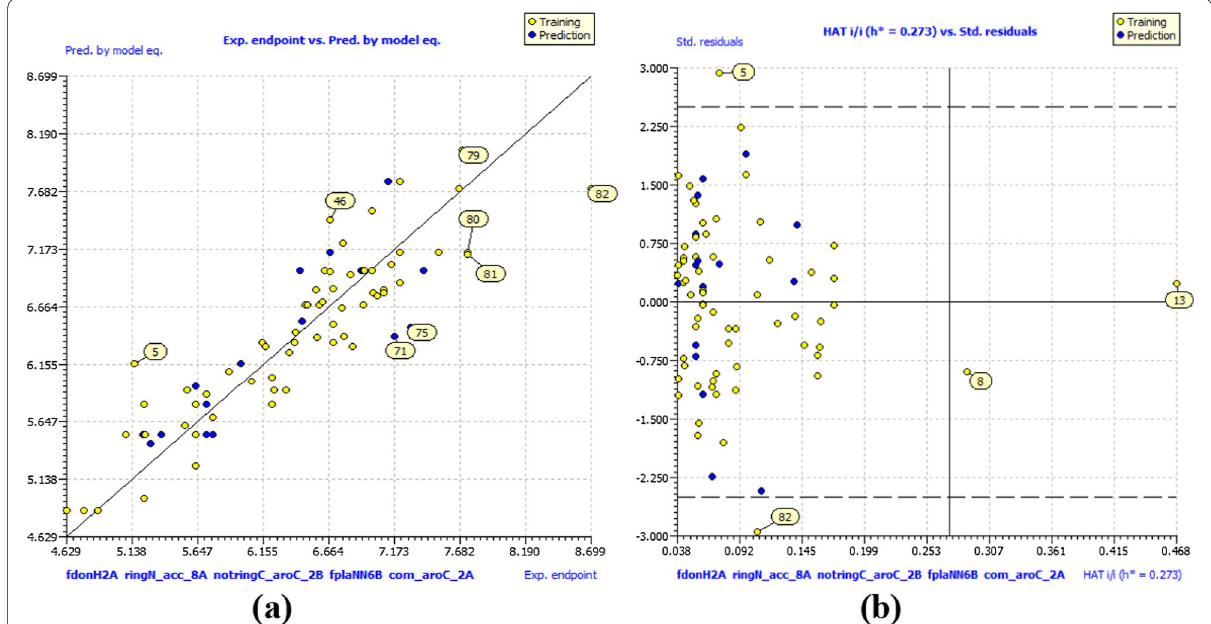
Fig. 5 Different graphs associated with the developed QSAR model (divided set model). a Experimental versus predicted P EC 50 , b Williams plot to assess applicability domain of